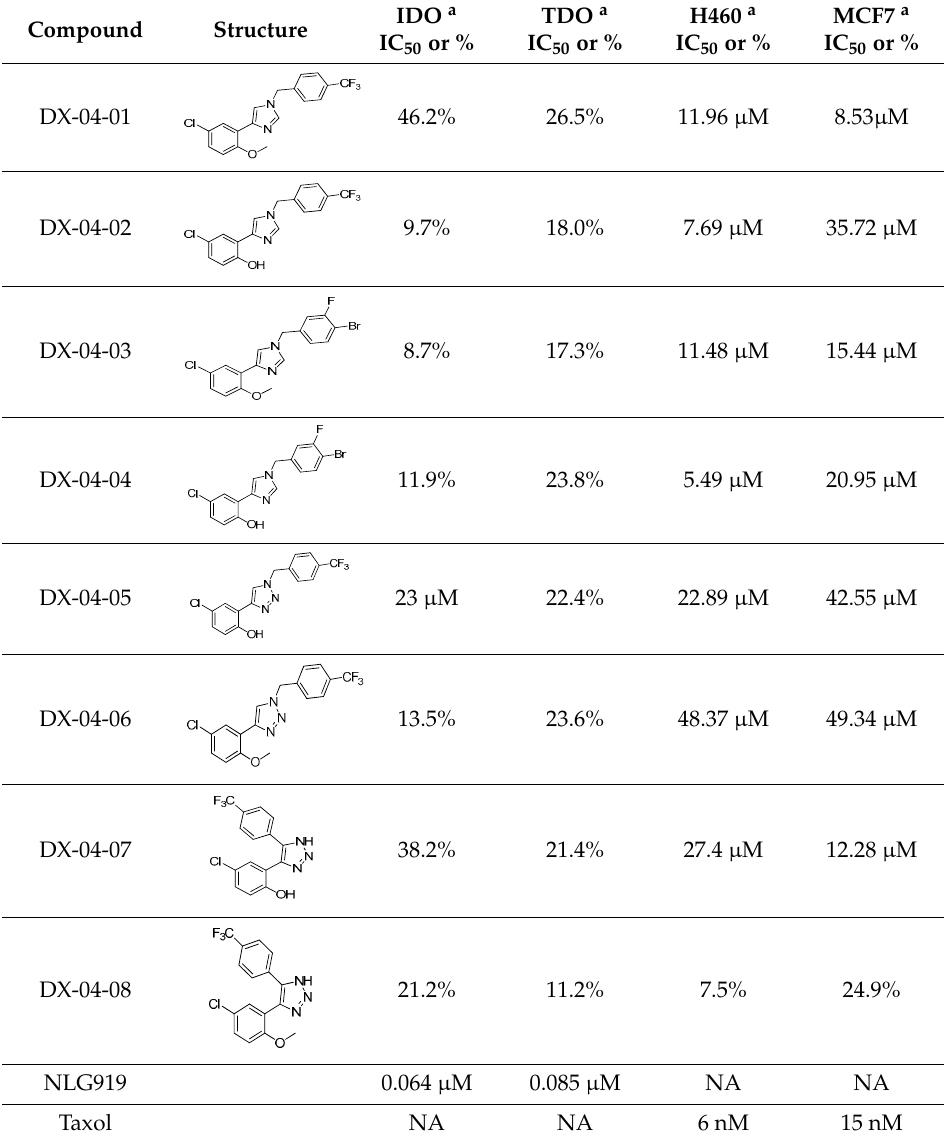
Table 4. In vitro IDO1 / TDO inhibitory activities and cell cytotoxicities of series 4. Table 4. In vitro IDO1/TDO inhibitory activities and cell cytotoxicities of series 4. Table 4. In vitro IDO1/TDO inhibitory activities and cell cytotoxicities of series 4. Table 4. In vitro IDO1/TDO inhibitory activities and cell cytotoxicities of series 4. Compound Compound Table 4. In vitro IDO1/TDO inhibitory activities and cell cytotoxicities of series 4. Compound Table 4. In vitro IDO1/TDO inhibitory activities and cell cytotoxicities of series 4. Table 4. In vitro IDO1/TDO inhibitory activities and cell cytotoxicities of series 4. Compound Compound Structure Table 4. In vitro IDO1/TDO inhibitory activities and cell cytotoxicities of series 4. Compound Table 4. In vitro IDO1/TDO inhibitory activities and cell cytotoxicities of series 4. Compound Compound